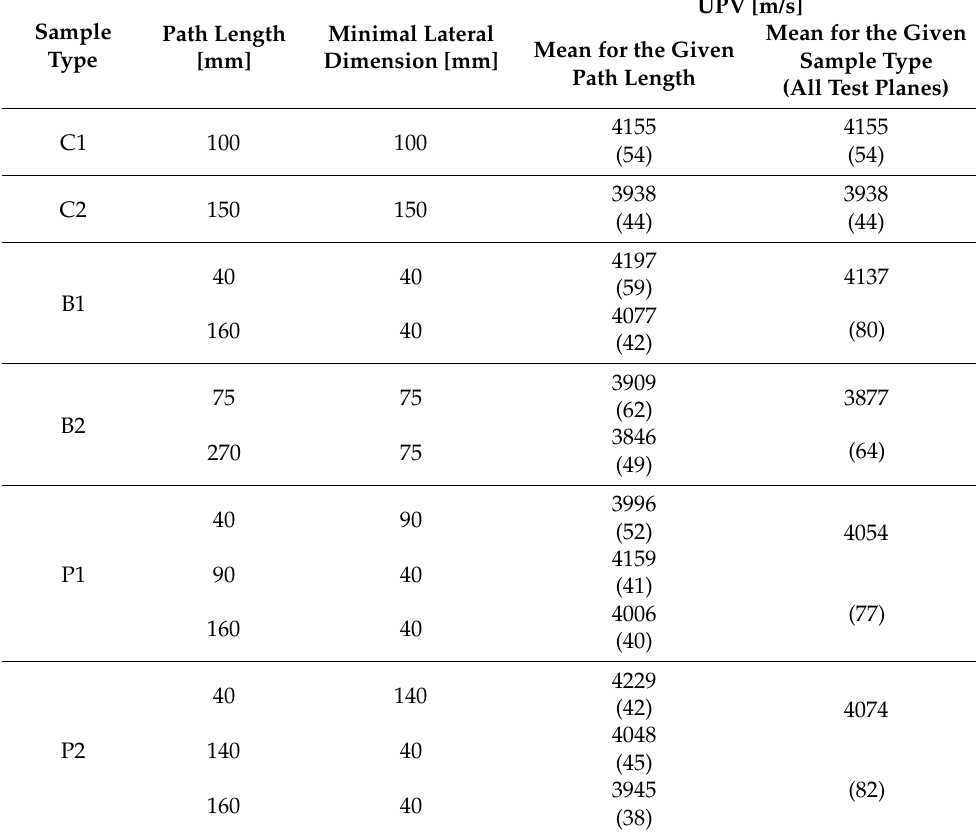
Table 4. Mean pulse velocity in epoxy concrete samples calculated for the given path lengths and sample type (all test